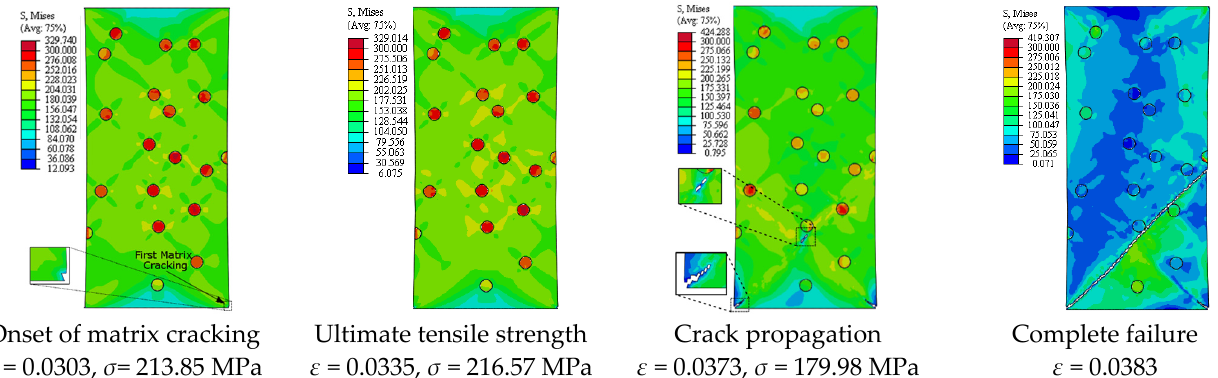
Onset of matrix cracking Figure 7. Failure propagation and von Mises stress distribution of A359/SiC composite at 5% VF (PS = 10 µm).